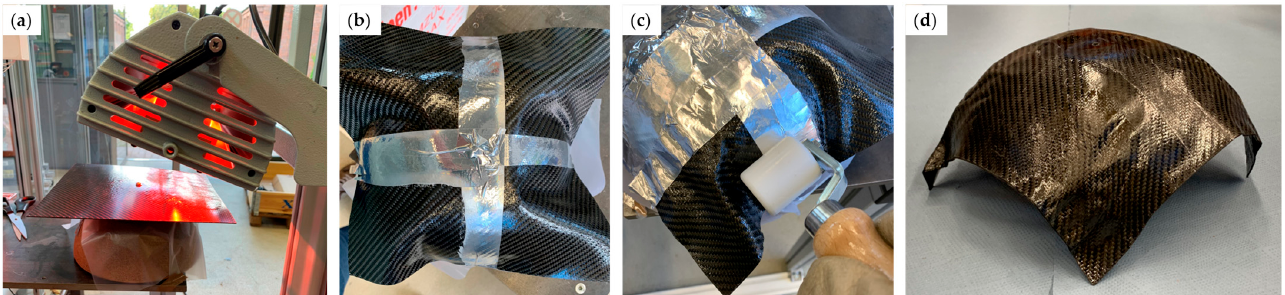
Figure 19. ( a ) Organo sheet with aluminum adhesive tape placed between an infrared heater and an infrared camera; ( b ) Infrared image of the heated organo sheet; ( c ) Temperature distribution along the line indicated in ( b ).